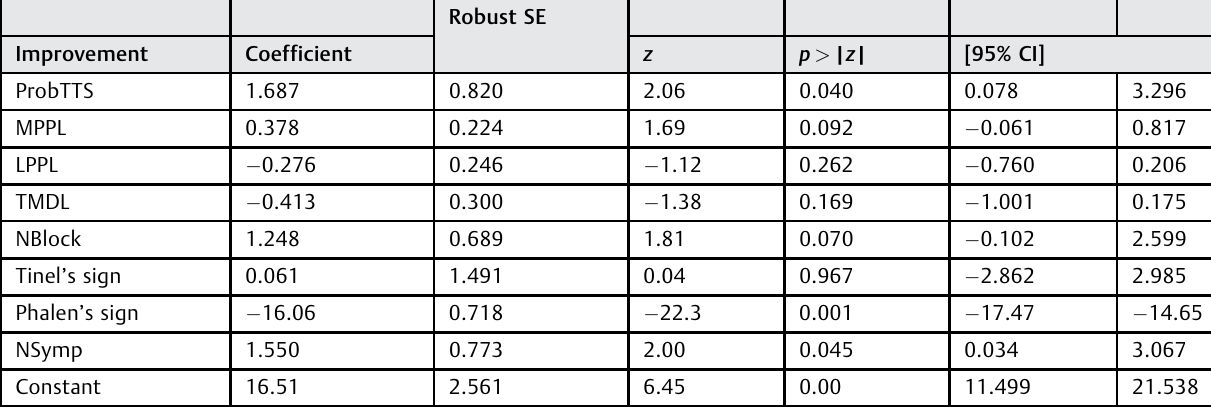
Table 4 Improvement outcome regression modeling group rating, selected nerve conduction study parameters, and clinical examination observations Robust SE